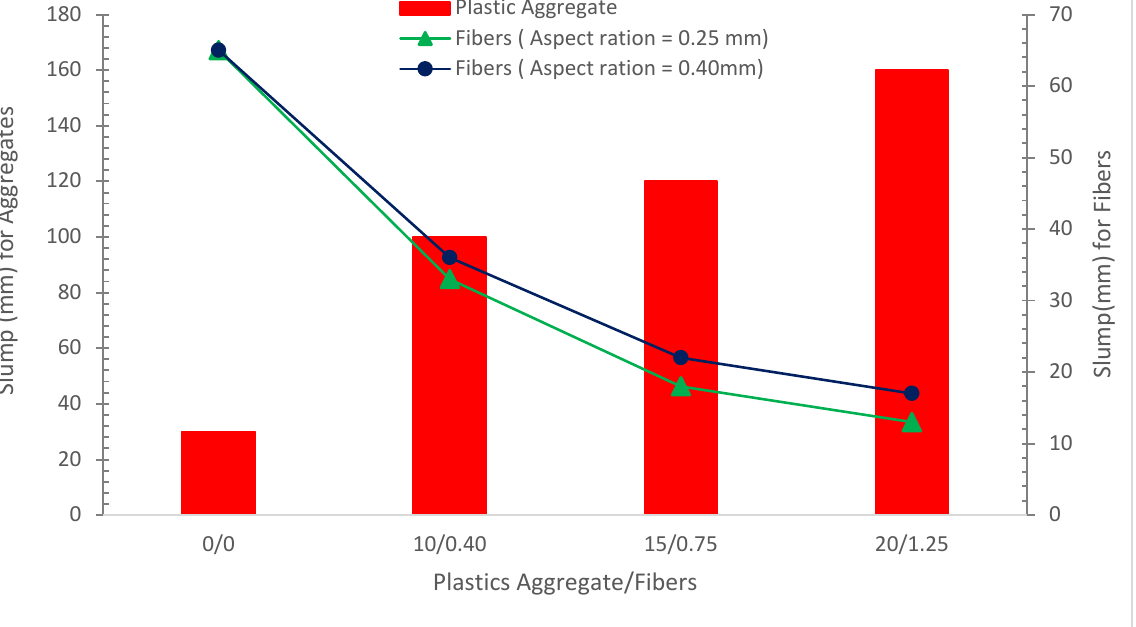
Figure 5. Slump Flow: Data Source [24,26].